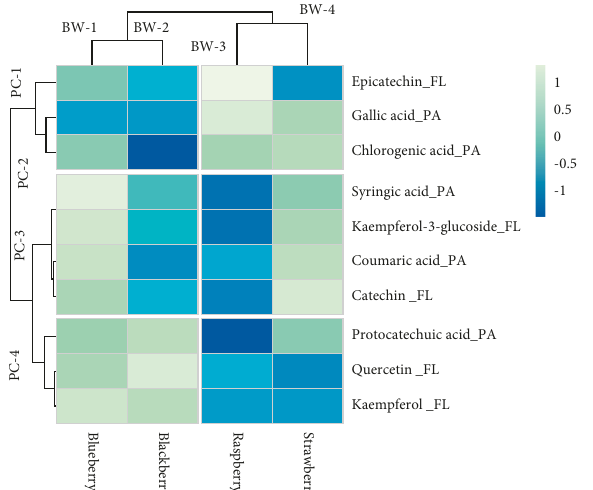
Figure 2: Heatmap showing phenolic compounds’ distribution and concentration among four samples of berries waste. Lighter green boxes mean concentrations are higher among different berries samples. Blue boxes mean lower concentrations. PA: phenolic acids; FL: flavonoids; BW 1–4: fruit berries waste; PC 1–4: phenolic compound clusters.